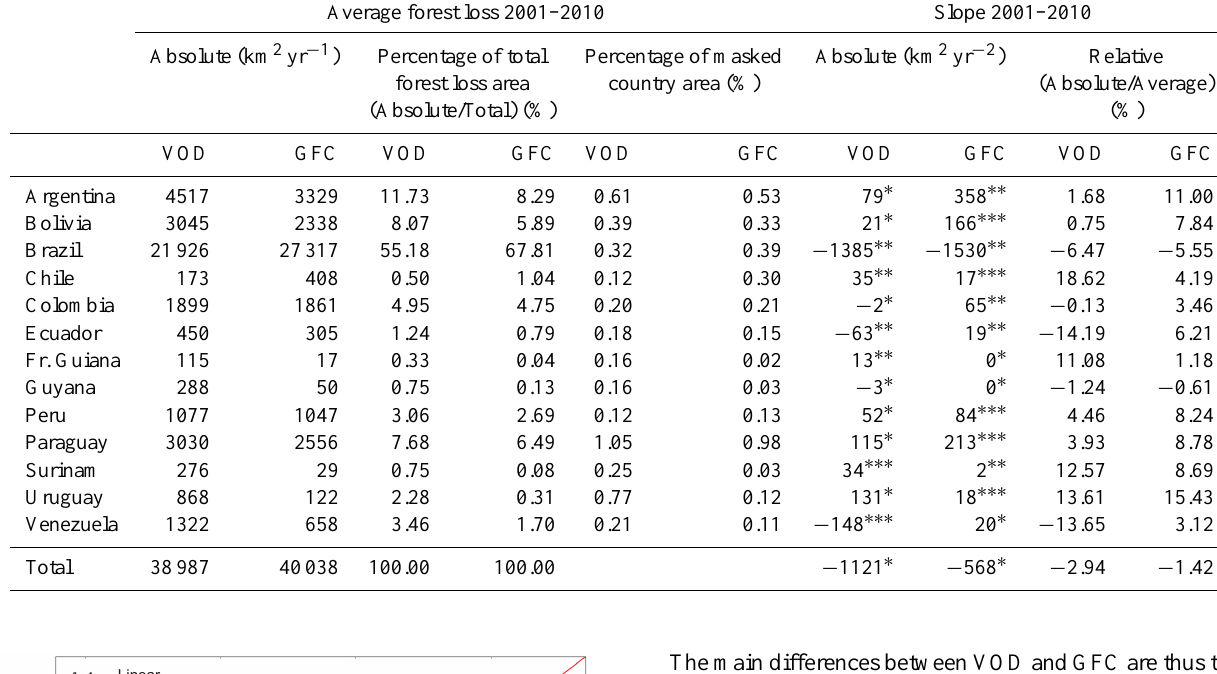
VOD estimates higher forest loss for the countries Uruguay, Paraguay and Chile compared to GFC. Furthermore, al- though VOD and GFC agreed on Brazil being the main driver of South American forest loss (54 % for VOD and 68 % for GFC), VOD estimates show higher interannual variability in this. This is mainly the case in 2001, 2006 and 2009, where VOD estimated 36–41 % less Brazilian forest loss compared to GFC (Table